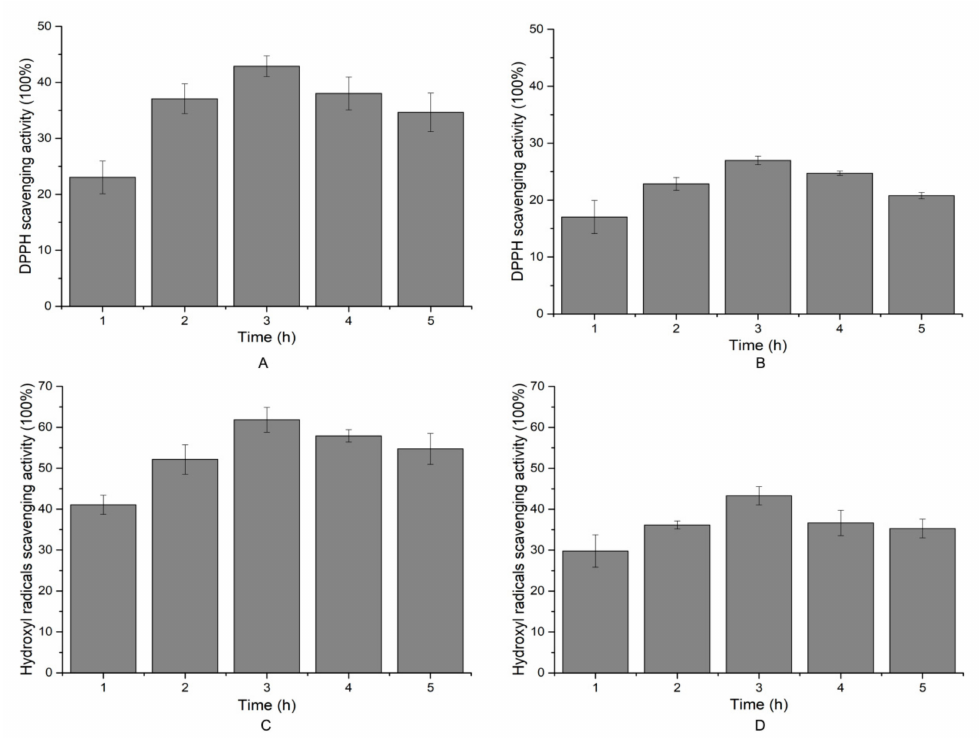
Figure 7. DPPH (1,1-diphenyl-2-picrylhydrazyl) and hydroxyl radical scavenging activity of hydrolysates. ( A ) DPPH and ( C ) hydroxyl radical scavenging activity of salmon skin collagen hydrolysates. ( B ) DPPH and ( D ) hydroxyl radical scavenging activity of porcine skin collagen hydrolysates. Values are expressed as the mean ± SD ( n =